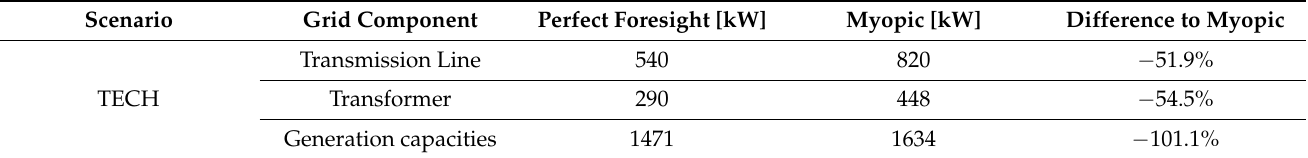
Table 5. Comparison of expanded grid capacities in the first optimization year of the TECH scenario. Scenario Grid Component Perfect Foresight [kW] Myopic [kW] Difference to Myopic Transmission Line 540 820 − 51.9% Transformer 290 448 − 54.5% TECH Generation capacities 1471 1634 −